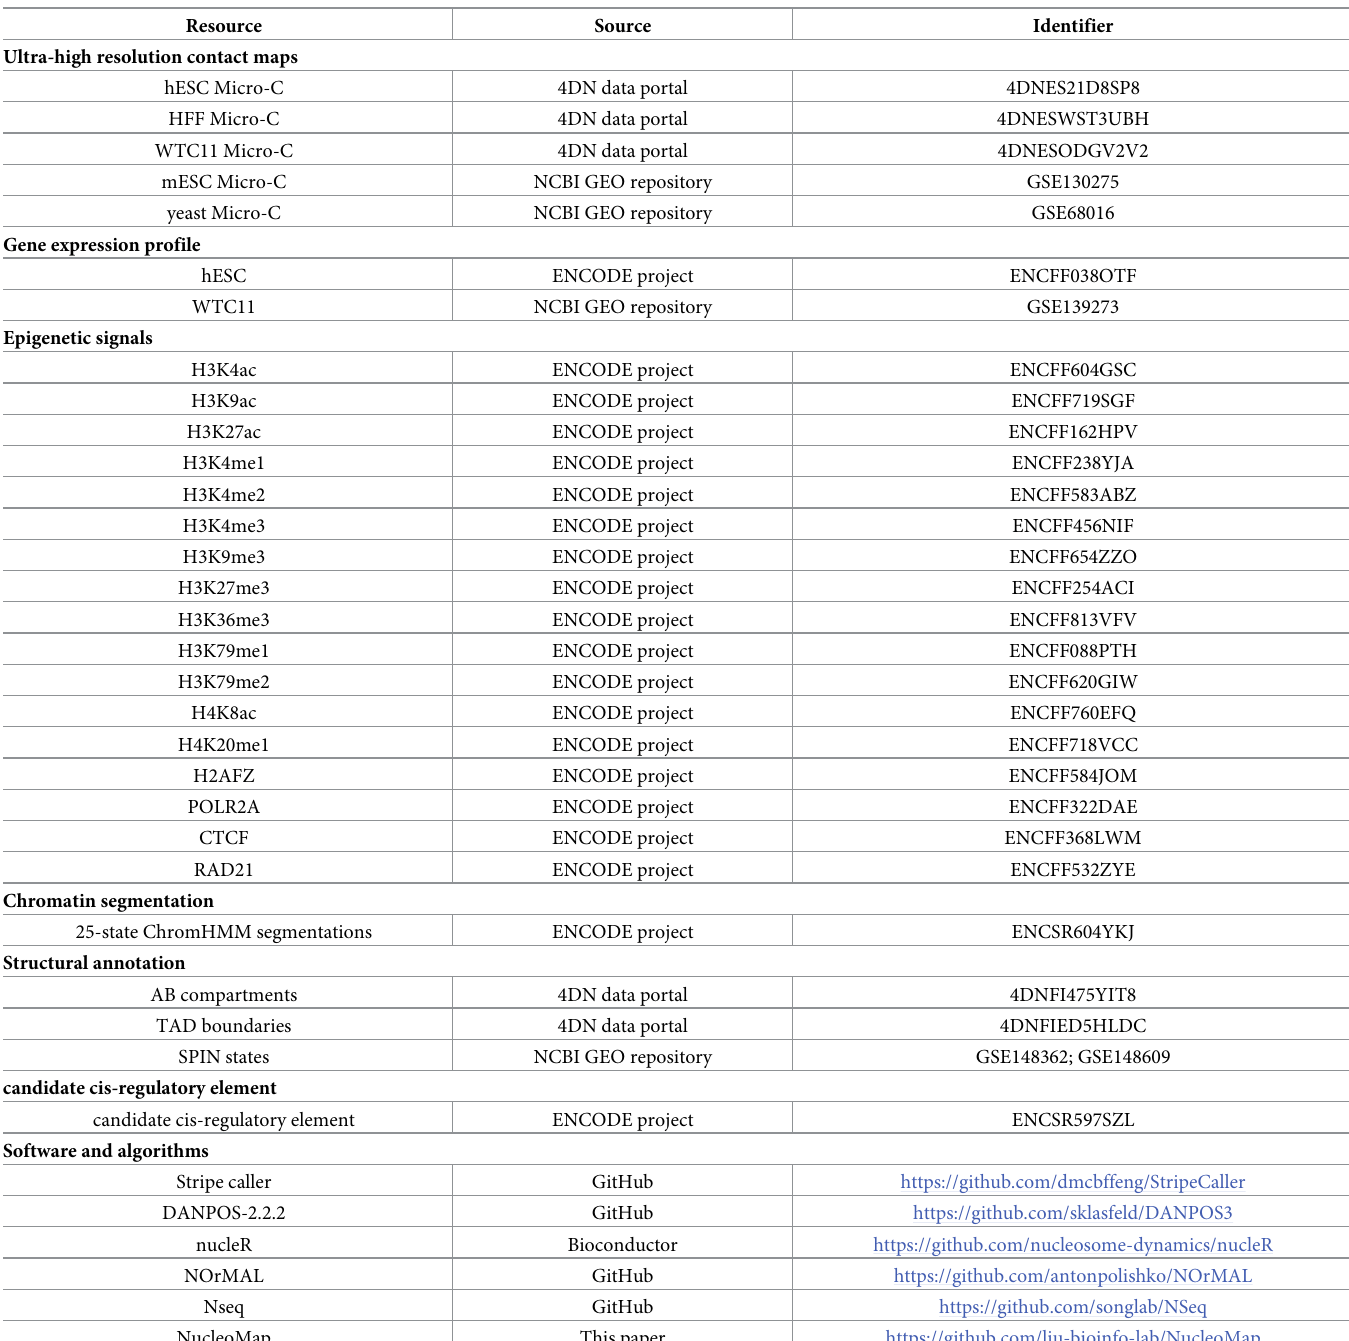
Table 2. Data and softwares involved in this